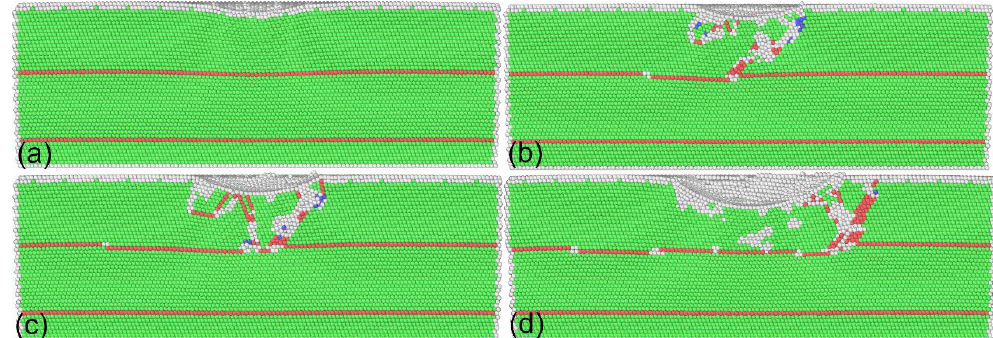
Figure 3. Cross-sectional views of twinned Al with an inclination angle of 0° under different displacements. Displacement: ( a ) 0.72 nm; ( b ) 0.88 nm; ( c ) 1.12 nm; and ( d ) 2.0 nm. Atoms are colored according to their CNA values.